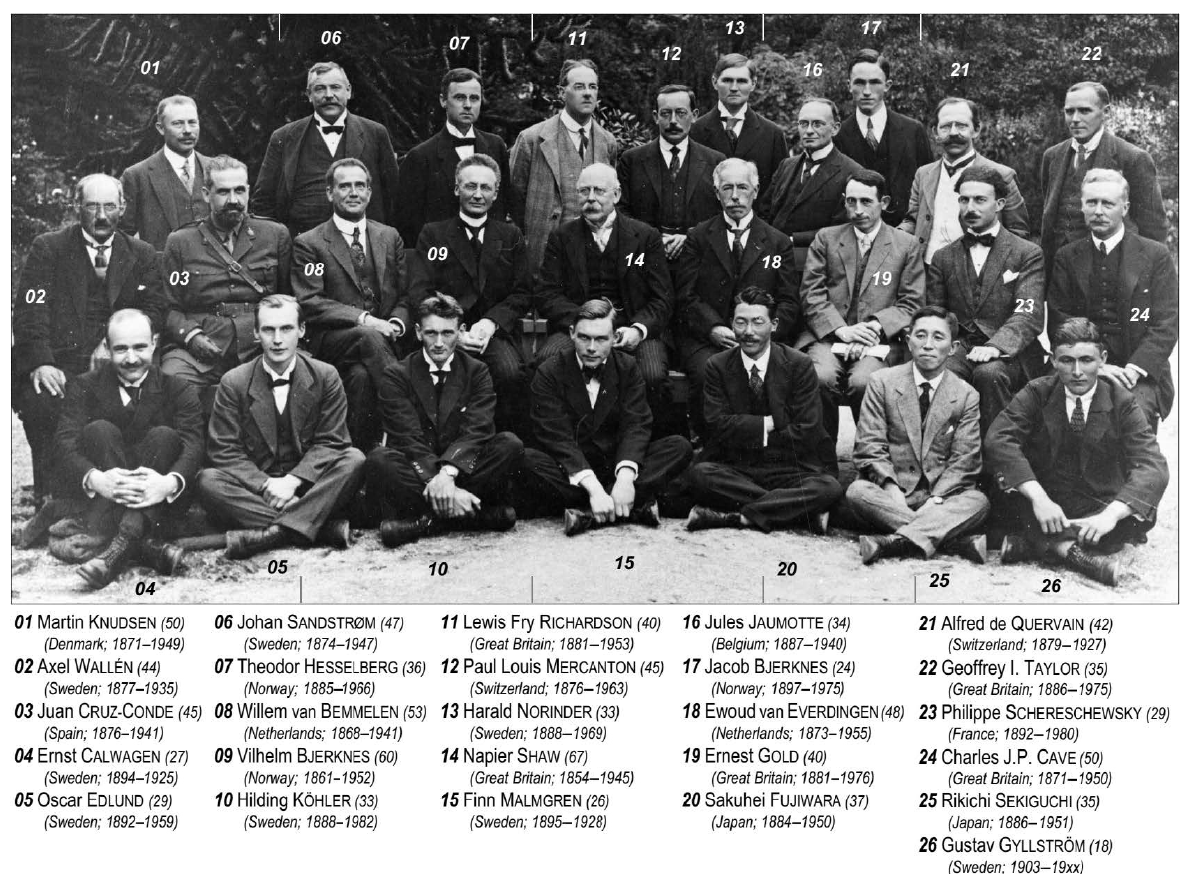
Figure 2. Participants at the eighth meeting of the International Commission for the Scientific Investigation of the Upper Air on 25 July 1921, in Bergen, Norway, 2 years after the formation of the Section of Meteorology. Numbering is in five columns, from left to right, with the following information for each person: number, first name, surname (age at conference, country of work – not necessarily nationality – and lifespan). The high-resolution scan was provided by the University Library in Bergen,